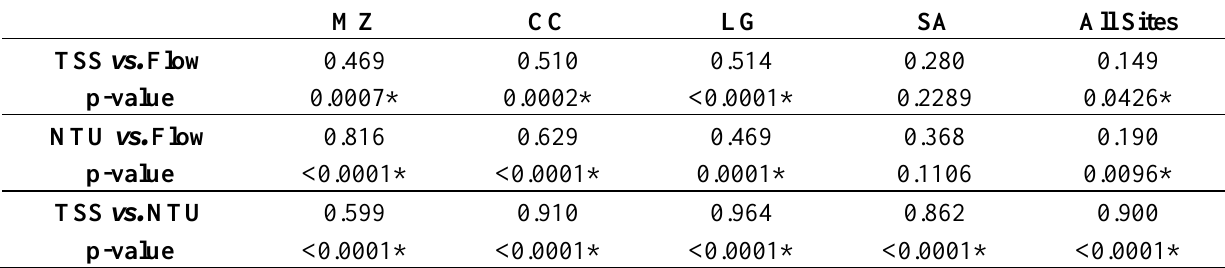
Table 3. Spearman Rank Correlation Value and p-value for Turbidity, Total Suspended Solids and Daily Mean Flow at Montezuma (MZ), Cow Creek (CC), Lower Gallinas (LG), and Spring Arroyo (SA) for 2003 &